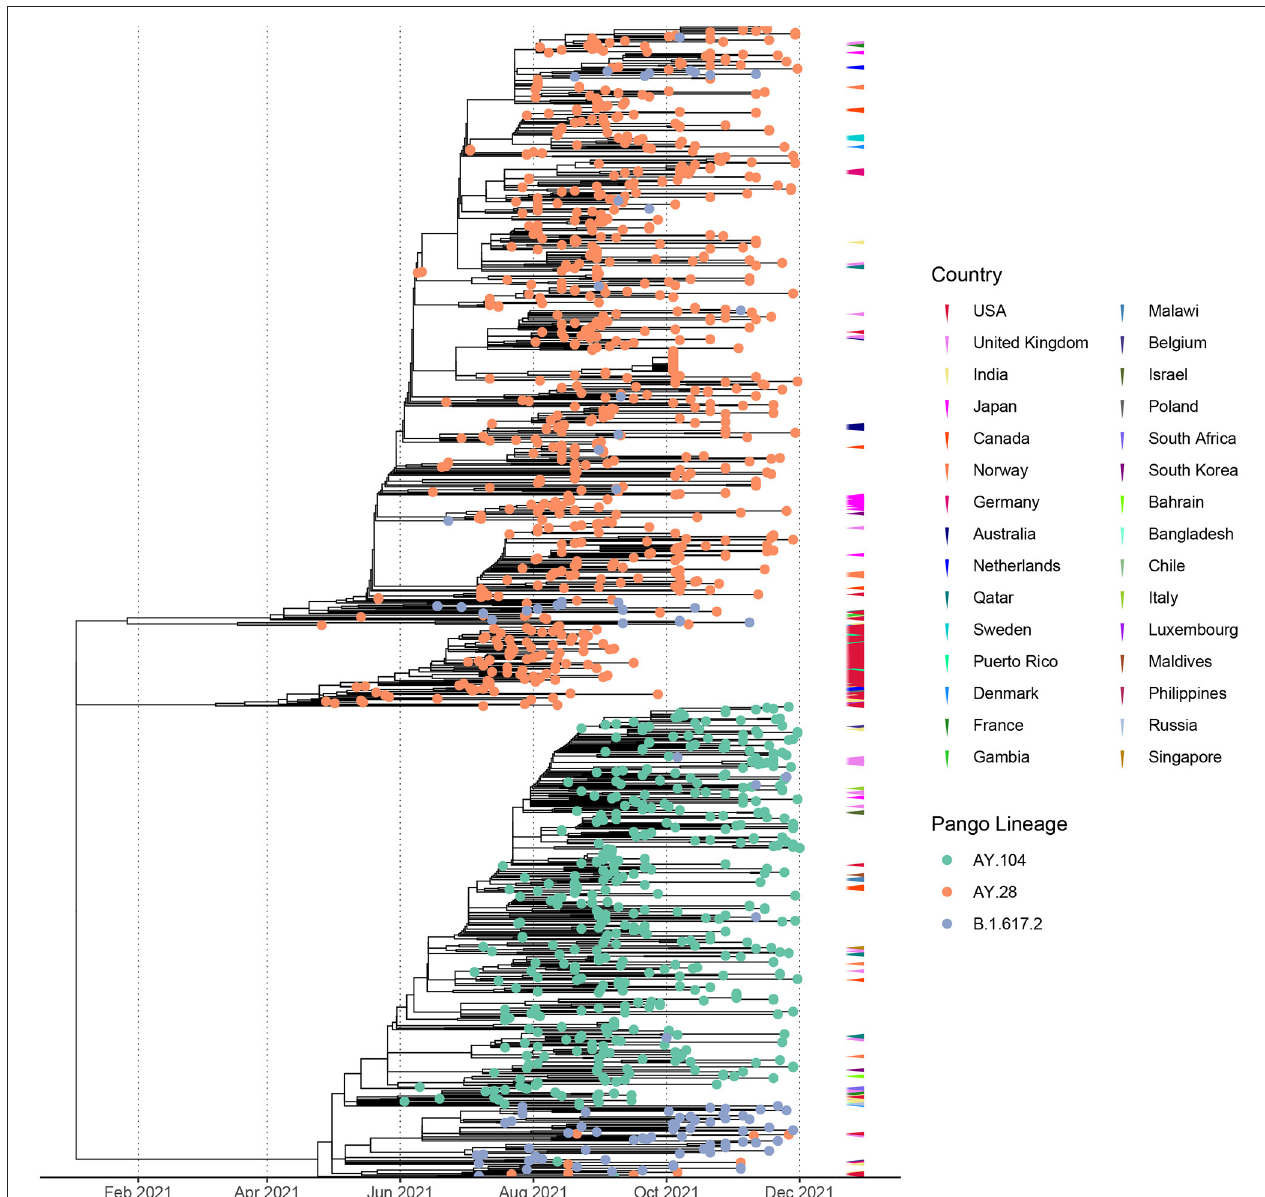
FIGURE 3 | Divergence times of the phylogenetic trees of the global AY.28 and AY.108 viruses using molecular clock. Time-resolved maximum-likelihood phylogenetic tree of AY.28 and AY.104 cases sequenced globally and B.1.617.2 sequences only originating from Sri Lanka. The molecular clock was inferred using TreeTime with an evolutionary rate of 1.1 × 10 − 3 substitutions/site/year with a standard deviation of 0.00004. Non-local cases of AY.28 and AY.104 are color-coded according to the originating country on the outer